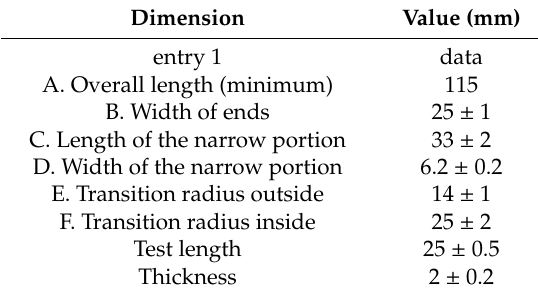
Figure 2. Shape of the dumb-bell test specimens [40]. Table 1. Dimensions of the dumb-bell specimens [40].